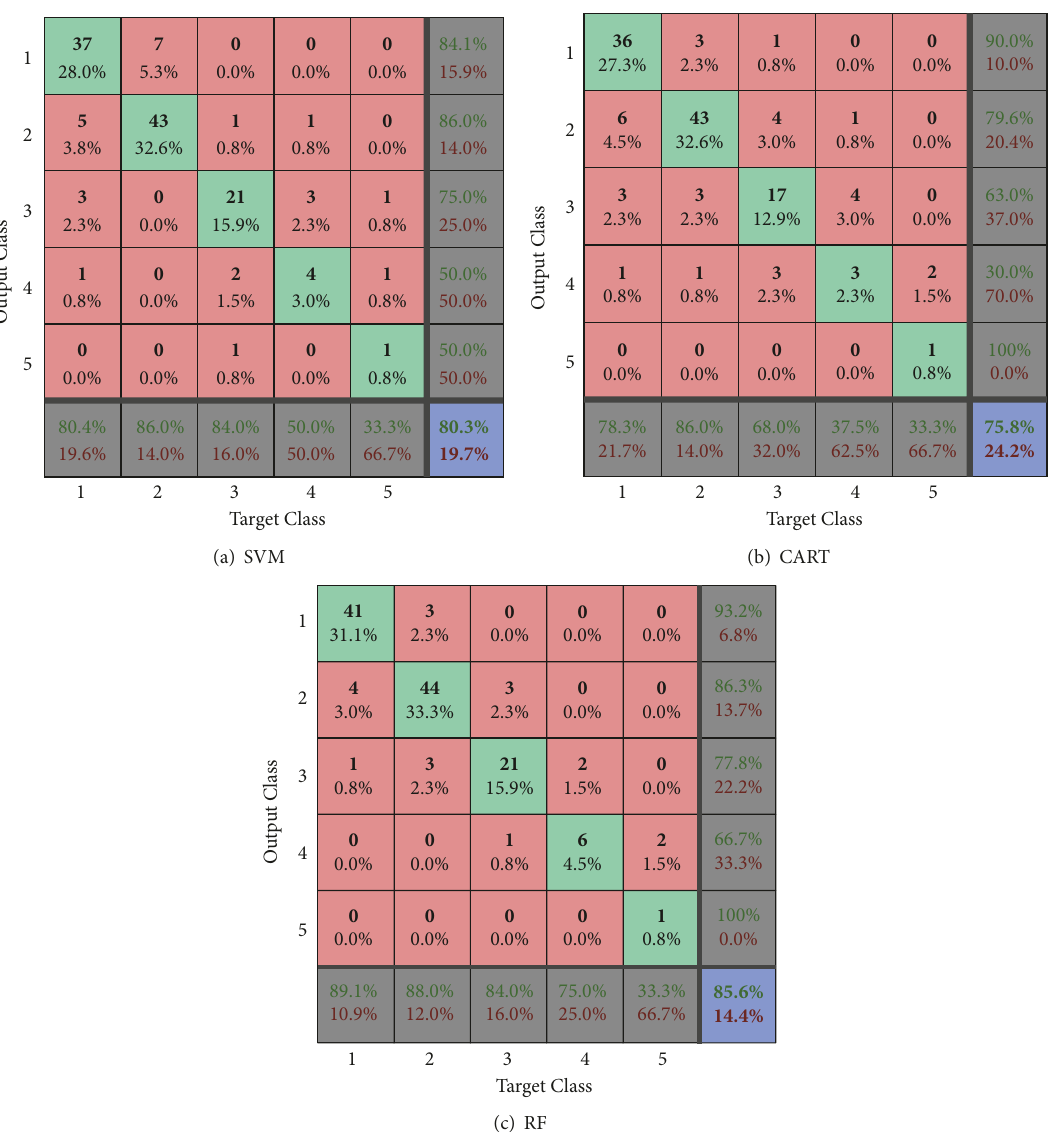
Figure 6: The confusion matrices for the results of these three